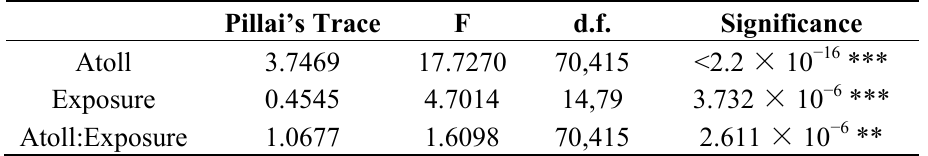
Table 2. Multivariate Analysis of Variance of the first 15 dimensions between locations and between sheltered and exposed sites (Stress1 0.326) from nm-MDS of the Bray-Curtis distance measure.